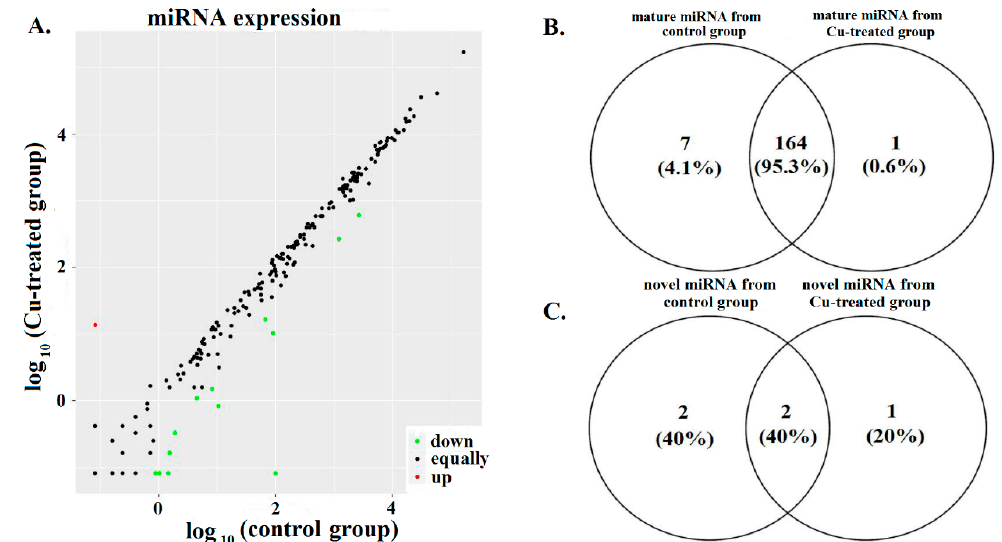
Figure 1. miRNA expression between the control and Cu-exposed group. ( A ) Scatter plot of hepatic miRNA expression levels in control group and Cu-exposed group. Each point represents a miRNA. The X and Y axes showed the normalized expression (log 10 NE) of miRNAs in each liver tissue. ( B , C ) Venn diagram compared the expression distribution of mature miRNAs and novel miRNAs between two groups. Numbers represents number and percent of co-expressed or differentially expressed miRNAs.